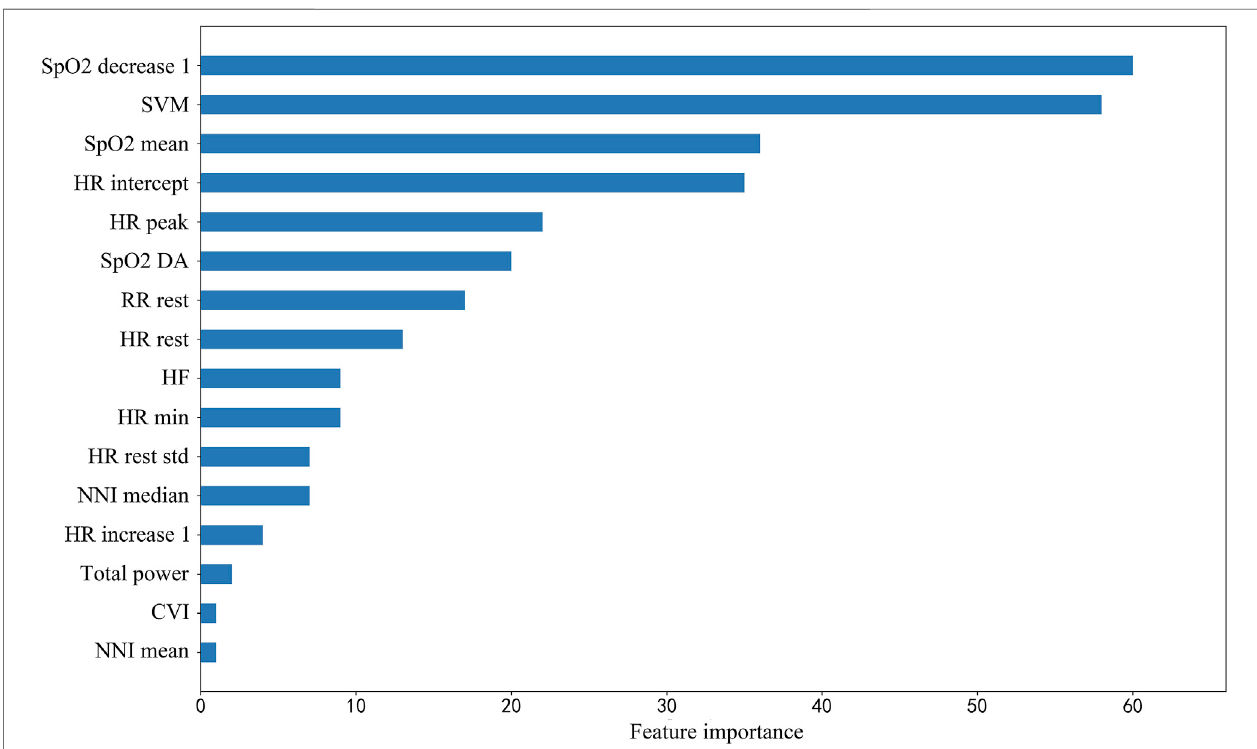
FIGURE5| FeatureimportancerankinginlightGBM model.SpO2_decrease1, Spo2decrease valuein1 min;SVM,signalvectormagnitude; SpO2mean1,mean valueofSpO2in fi rst1 min;HRintercept,heartrateintercept;HRpeak,peakheartrate;SpO2DA,SpO2desaturationarea;RRrest,breathrateduringrestsegment;HR rest, heart rate during rest segment; HF, high frequency power, one of HRV parameters; HR min, minimum heart rate; HR rest std, standard deviation of beat-to-beat heart rate during rest segment; HR increase 1, heart rate increase value in 1 min; Total power, one of HRV parameters; CVI, cardiac vagal index, one of HRV parameters; NNI mean, mean value of normal-to-normal